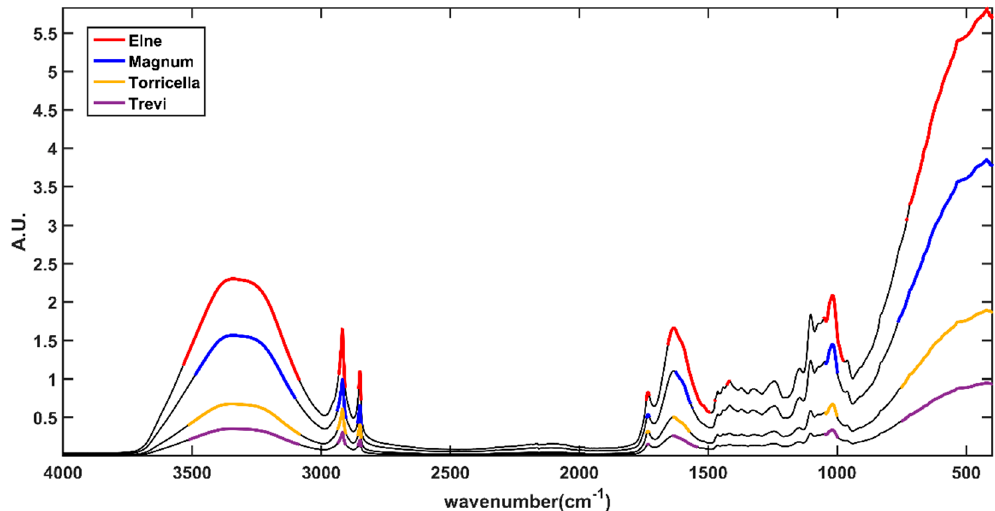
Figure 4. VIP analysis. Black lines represent the average spectra per class. The upmost line is the average spectrum for class Elne. The middle lines are average spectra for class Magnum and class Torricella Peligna Black, respectively. The lowest line is the average spectrum for class Trevi Black. Bold-colored variables are those corresponding to VIP > 1.